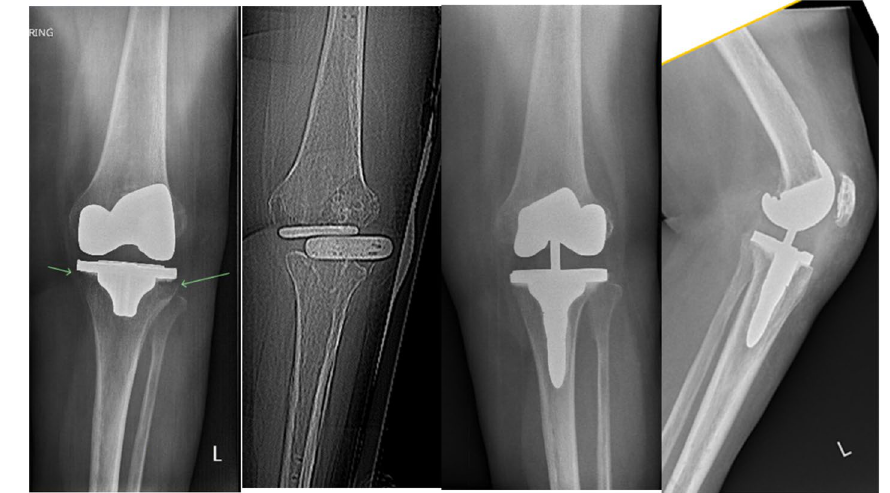
Fig. 20 Pre‑ and postoperative radiographs of the patient for the preoperative planning in Fig. 15